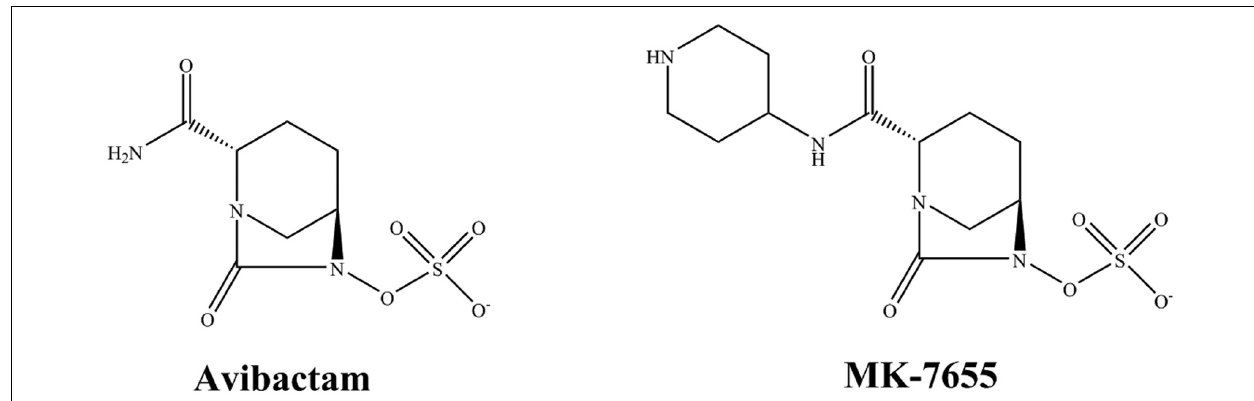
FIGURE 2 | Chemical structures of